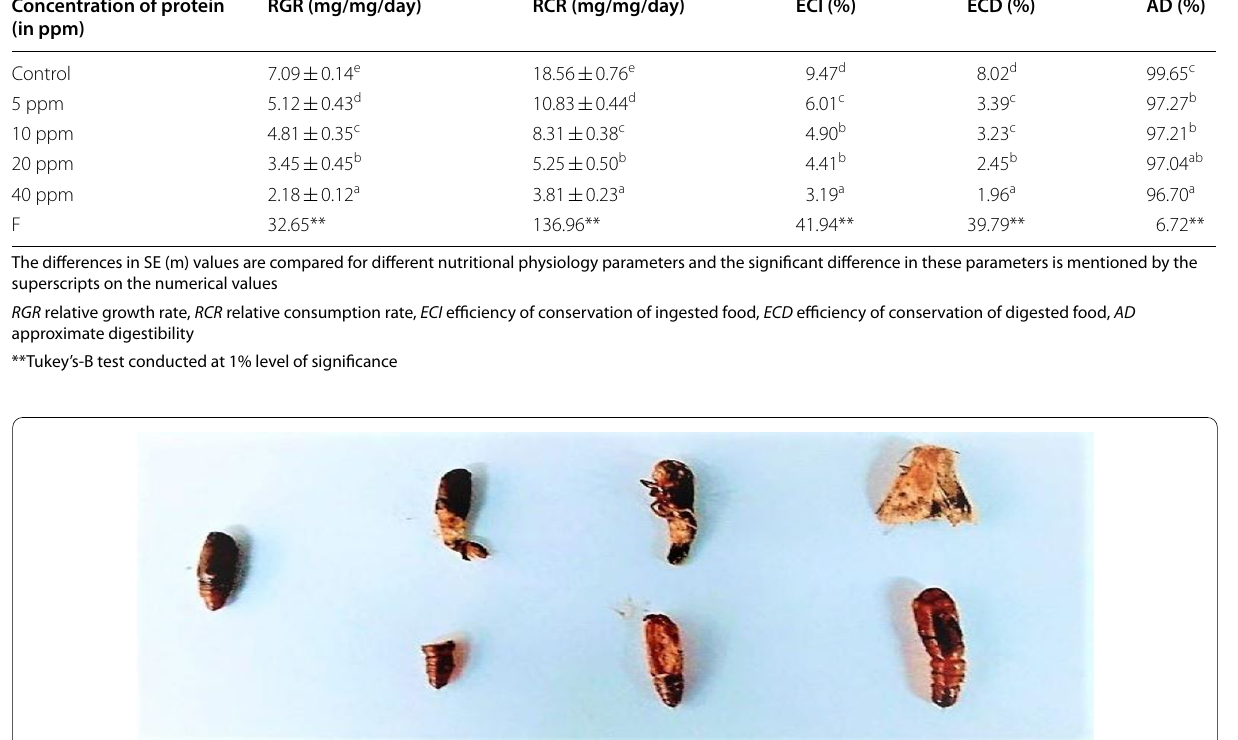
Sitobion avenae